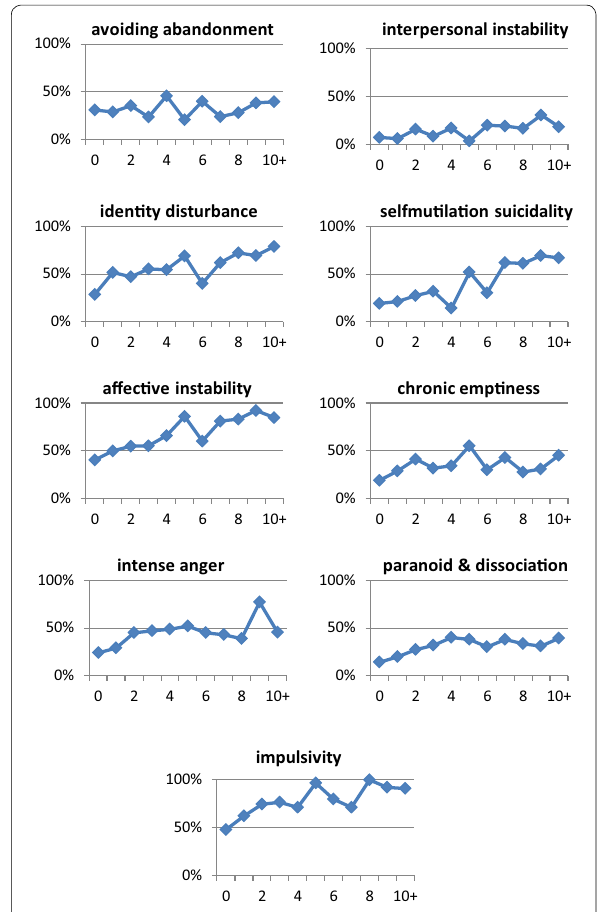
Fig. 3 Individual BPF in relationship to full-duration DSM-IV episode frequency. Axis X represents the number of episodes; axis Y repre- sents proportion of patients with positive BPD